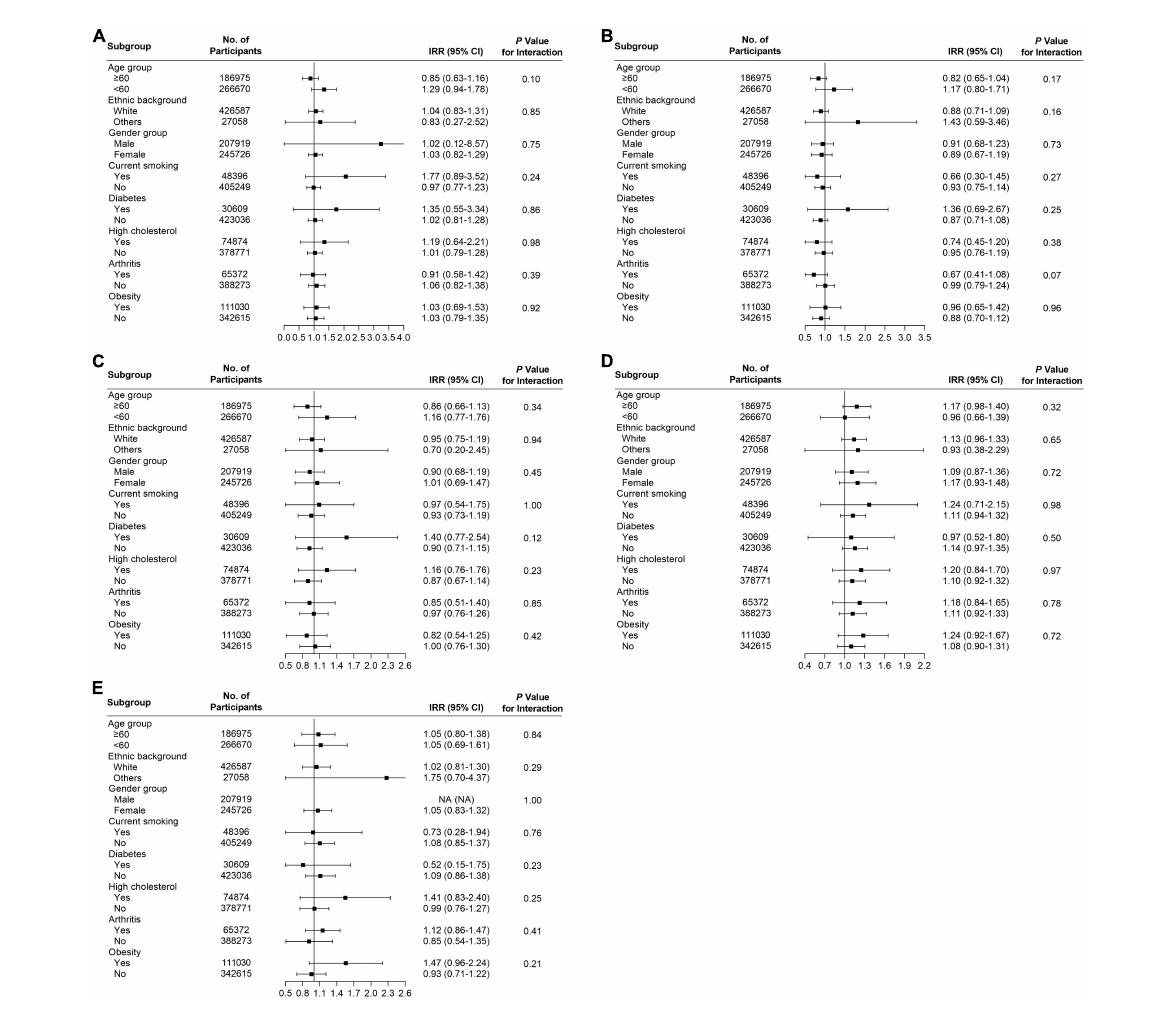
FIGURE4 Subgroup analysis for (A) breast cancer, (B) colon cancer, (C) esophagus cancer, (D) lymphoma hematopoietic cancer, and (E) ovary cancer to analyze the potential modification effects between age, ethnic background, gender, smoking, diabetes, high cholesterol, arthritis, and